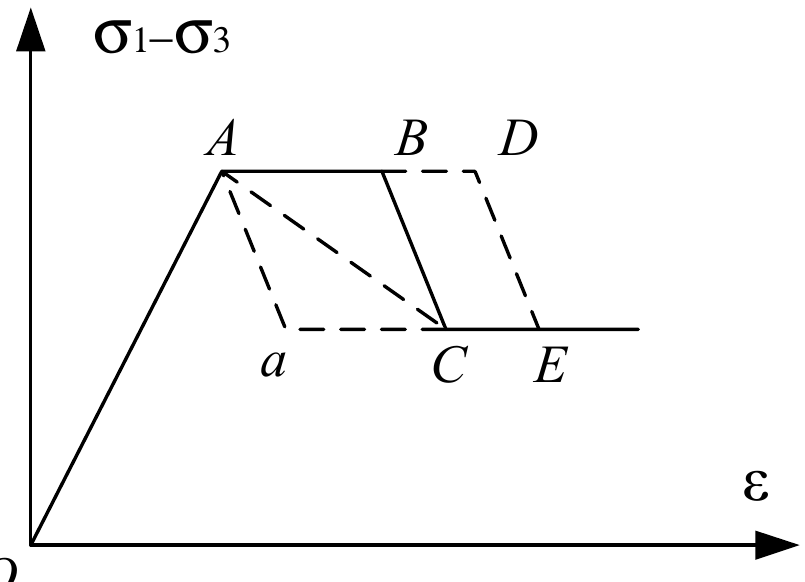
Figure 3. Schematic diagram of calculation parameters of plasticity index.